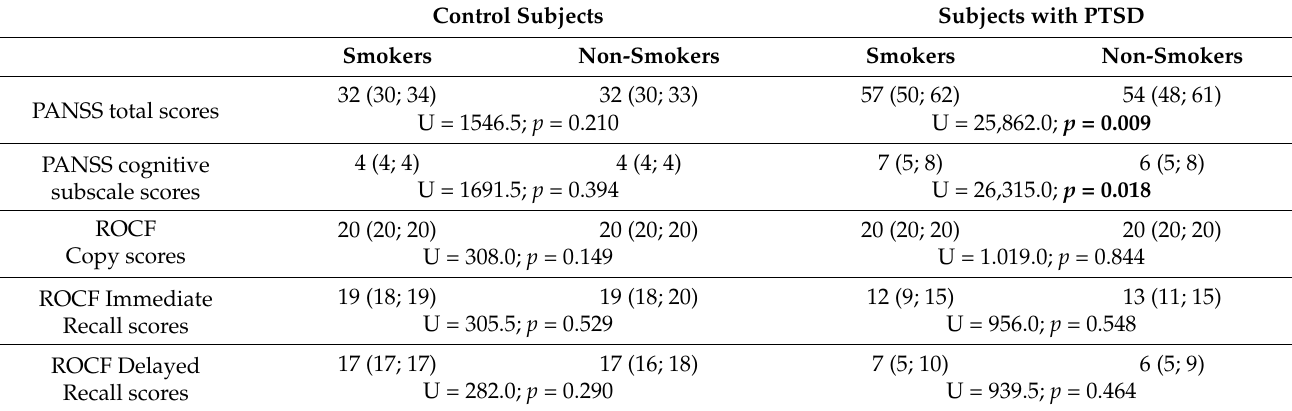
Table 3. Scores of the PANSS total and PANSS cognitive subscales and the ROCF copy, immediate recall, and delayed recall tests in control subjects and veterans with PTSD, depending on smoking status. The data is shown as median and interquartile range (25th; 75th percentile), while p values in bold represent statistical